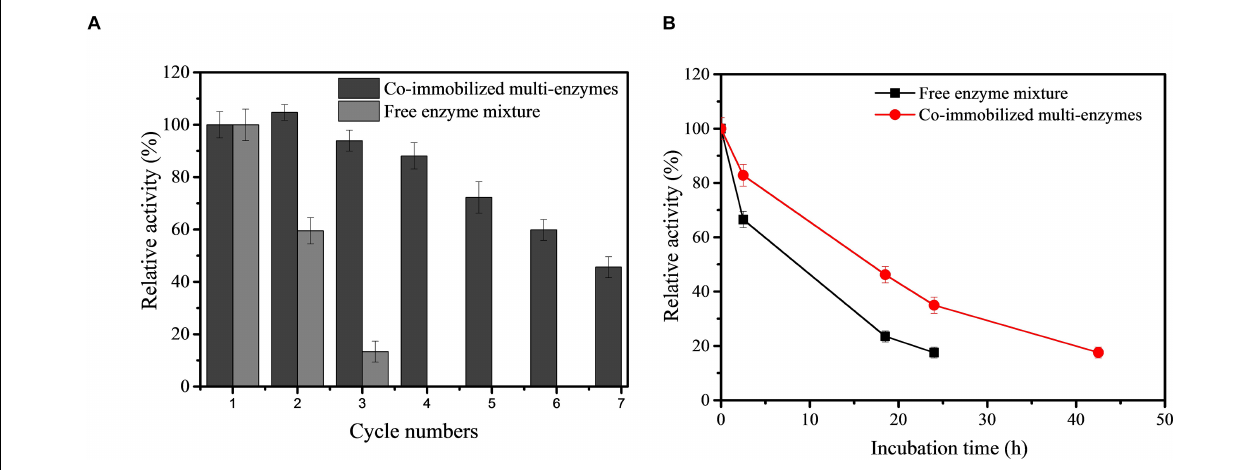
FIGURE 6 | Recycling stability of free enzyme mixture and co-immobilized multi-enzymes (A) and the thermostability of free enzyme mixture and co-immobilized multi-enzymes (B)